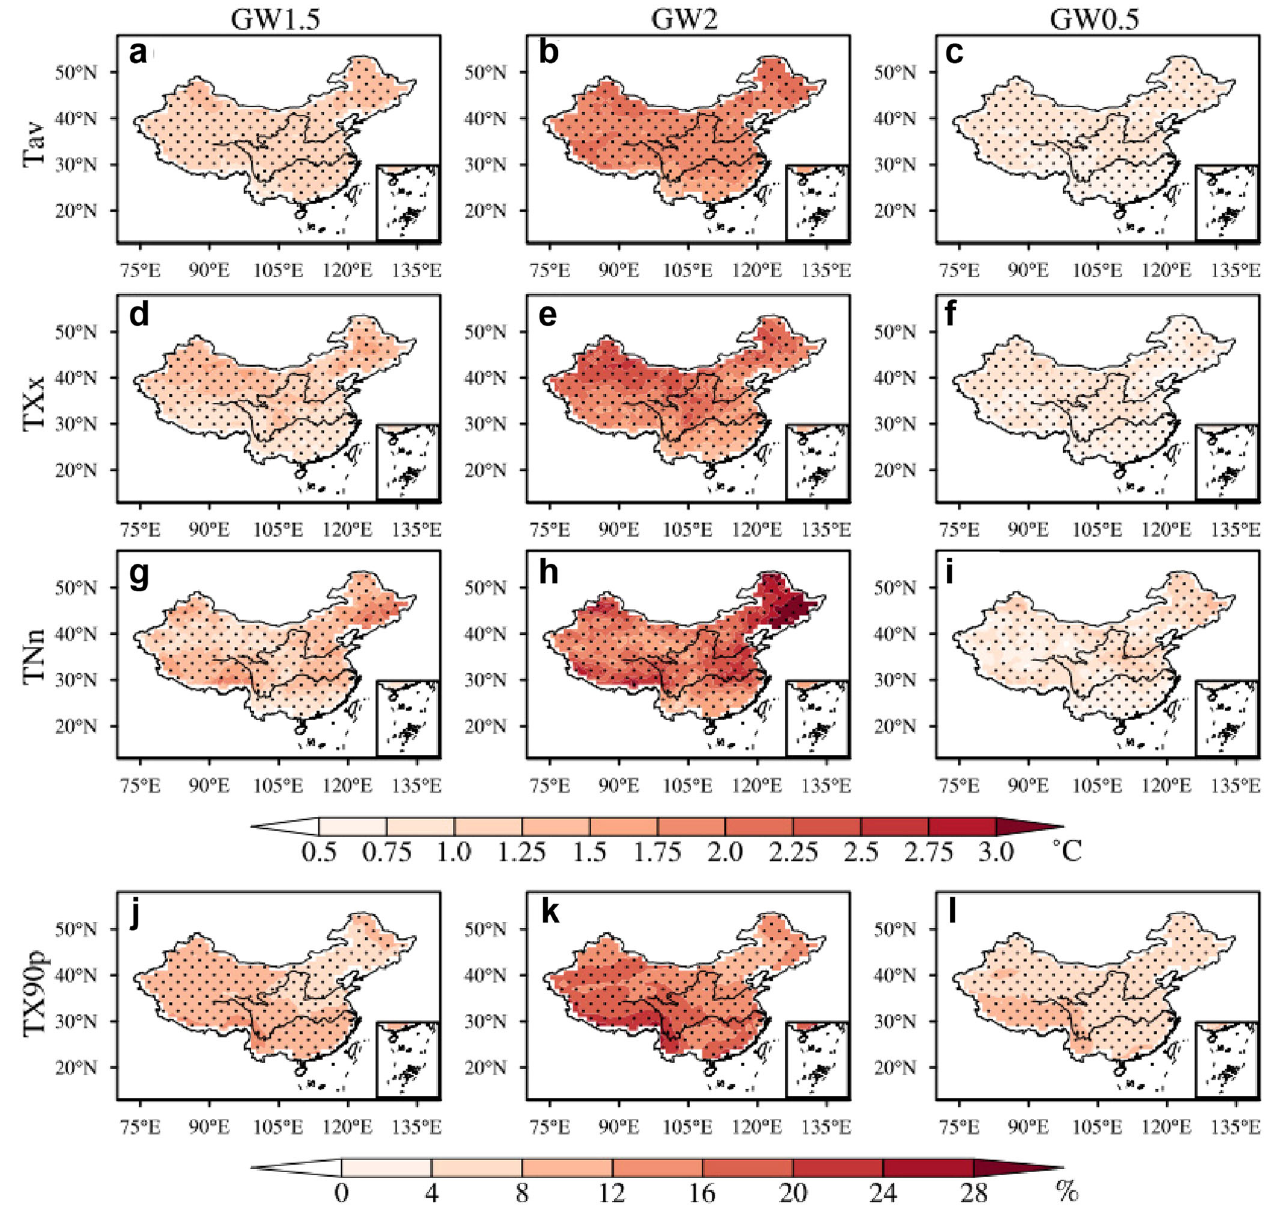
Fig. 4 Mean temperature change (Tav) and three extreme temperature indices (TXx, TNn, and TX90p) changes in China at GW1.5 and GW2.0. The left-hand column shows the changes at GW1.5 while the middle-hand column shows GW2.0, and the right-hand column shows additional changes due to the additional 0.5 °C warming (GW2 as compared with GW1.5). Results are based on the multi-model ensemble mean (MMEM) of Coupled Model Intercomparison Project Phase 6 (CMIP6) models relative to 1995 – 2014. Areas with signi fi cant changes above 95% con fi dence are marked with black